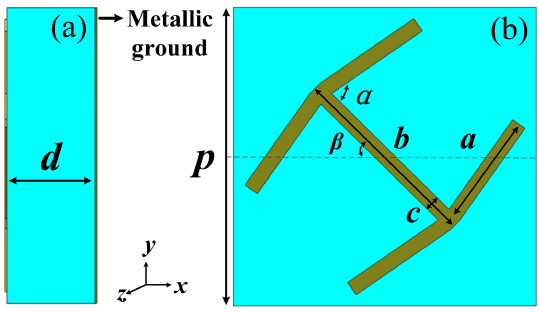
Figure 1. ( a ) Side view and ( b ) front view of the polarization conversion metasurface (PCM)